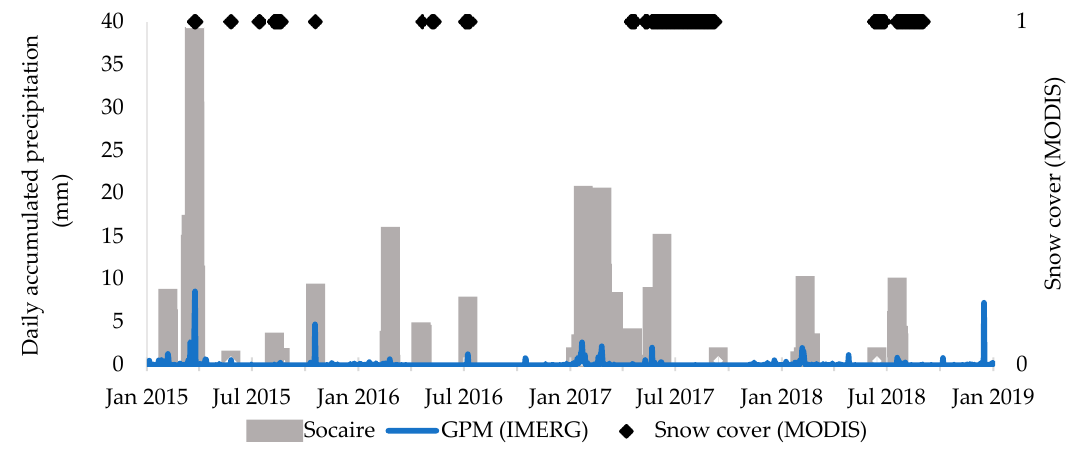
Figure 5. Meteorological data of the station Socaire, GPM (IMERG) and snow cover between January 2015 and December 2018, where 0 is no cover, and 1 indicates snow cover. Temperature data indicated average values of 12 °C for the winter months and 23 °C for summer, with the highest temperatures recorded during January. Figure 3 shows relative humidity (RH) through the study period. As for the relative humidity (RH), the Socaire station registered high values (38%) during the Altiplanic winter months (December to March), and an average 21% in southern winter (June to September). The wettest year was 2017 (25% average) coincident with the La Niña event and the driest 2016 (19% average). Finally, the wind does not have a specific temporal pattern.